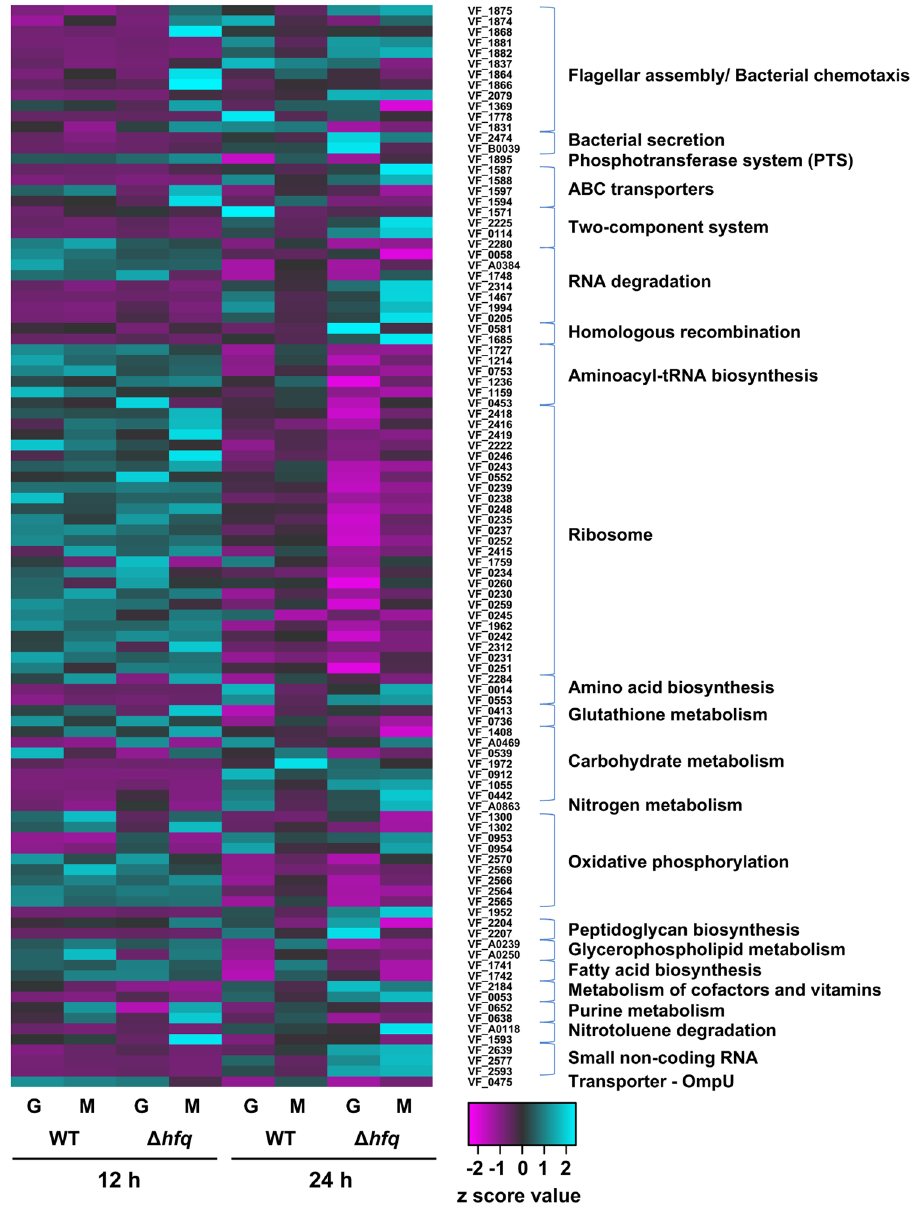
Fig. 8 Heat map depicting the clustering patterns of the eight treatments by KEGG pathways associated with the proposed function of V. fi scheri genes at 12 and 24 h. Gene changes governing fl agellar assembly and bacterial chemotaxis labeled at the top. Colors represent the differential abundance of individual genes listed by V. fi scheri identi fi cation number (VF-ID) for both wild type (WT) and Δ hfq mutants under simulated microgravity (M) and normal gravity (G) conditions. Figure and modi fi ed caption reprinted from Duscher et al. 30 under